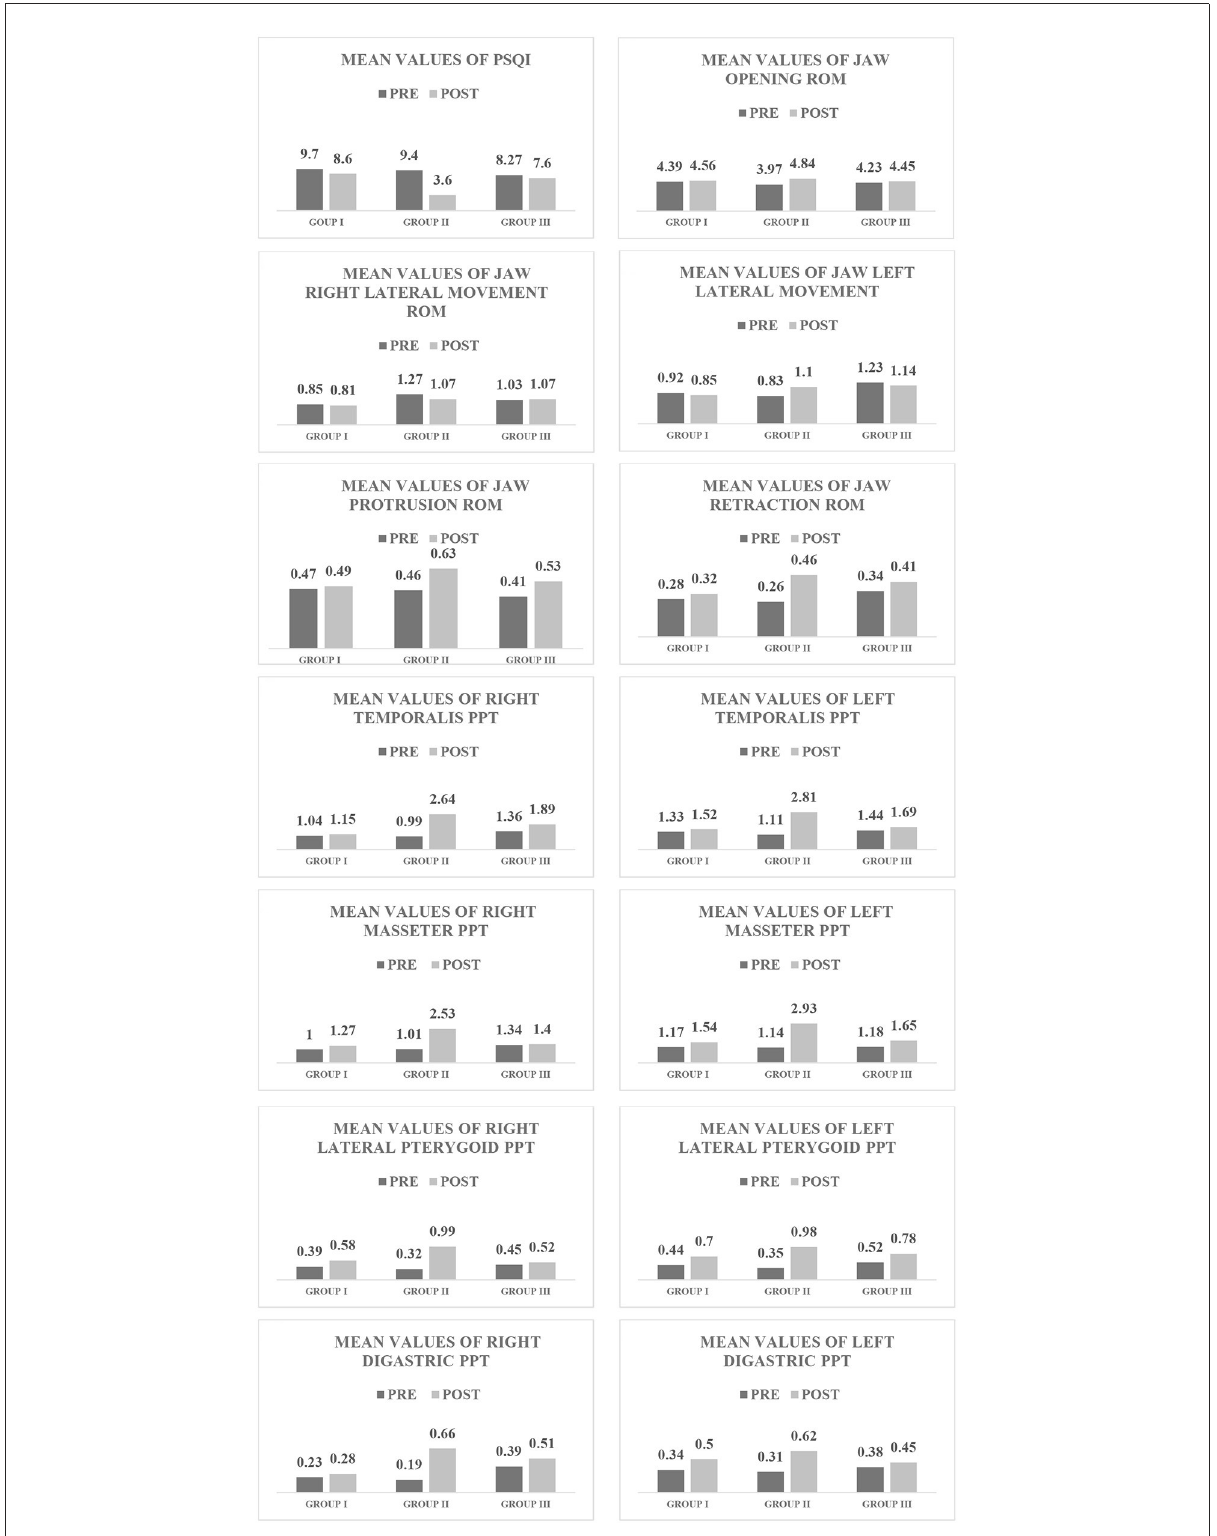
FIGURE2 Mean PSQI, jaw ROM, and PPT values in each group in the “pre” and “post” test